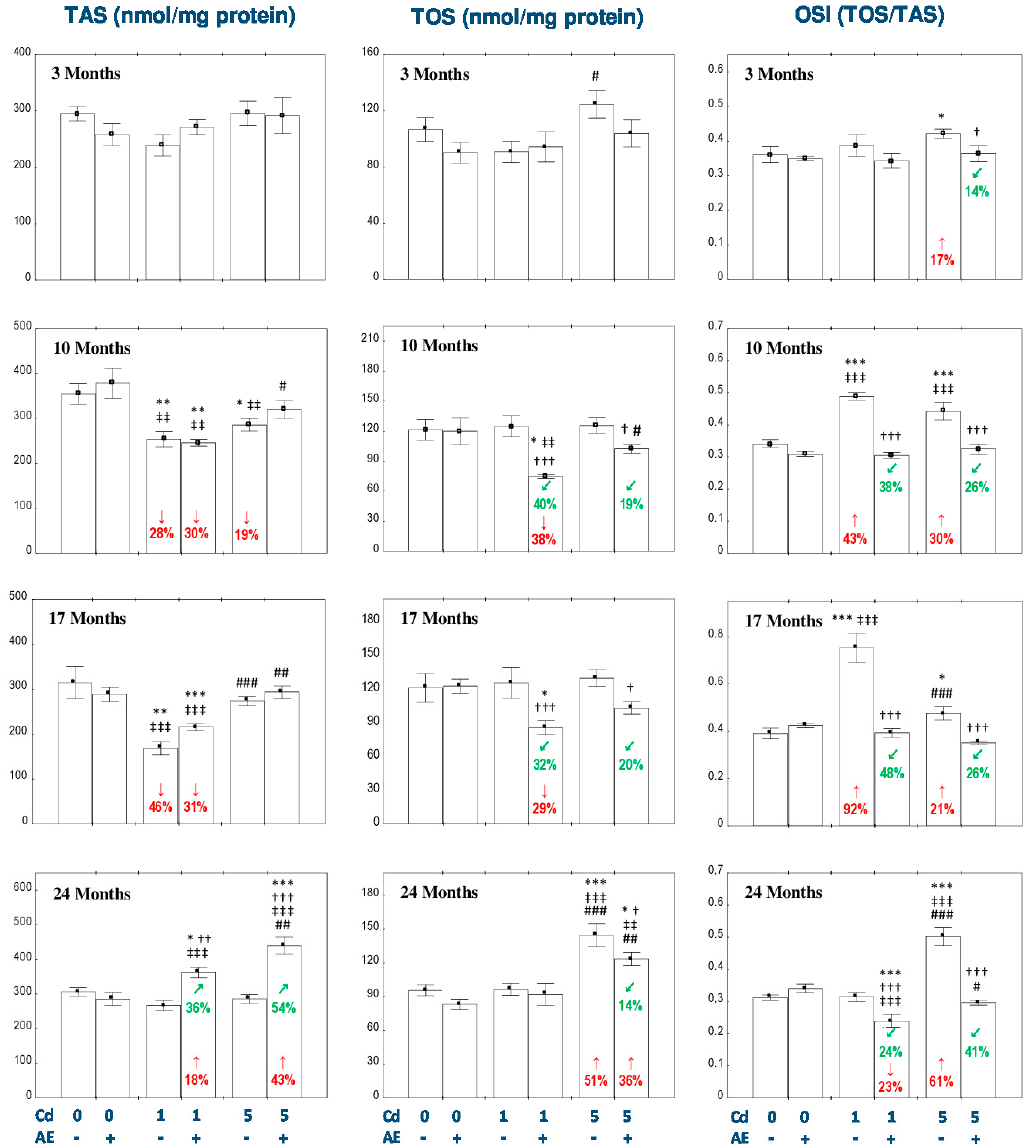
Figure 5. The effect of the extract from the berries of Aronia melanocarpa L. (AE) on the total antioxidative status (TAS), total oxidative status (TOS), and the oxidative stress index (OSI) in the liver of rats exposed to cadmium (Cd). The rats received Cd in the diet at the concentration of 0, 1, and 5 mg Cd/kg and/or 0.1% aqueous AE (+) or not (-). Data are presented as mean ± SE for eight rats, except for seven animals in the AE, Cd 1 , and Cd 5 group after 24 months. Statistically significant differences (ANOVA, Duncan’s multiple range test): * p < 0.05, ** p < 0.01, *** p < 0.001 vs. control group; † p < 0.05, †† p < 0.01, ††† p < 0.001 vs. respective group intoxicated with Cd alone; ‡‡ p < 0.01, ‡‡‡ p < 0.001 vs. group receiving AE alone; # p < 0.05, ## p < 0.01, ### p < 0.001 vs. respective group receiving the 1 mg Cd/kg diet (alone or with AE). Numerical values in bars disclose the percentage changes in comparison to the control group ( ↓ , decrease; ↑ , increase) or the respective group receiving Cd alone ( ↙ , decrease; ↗ , increase).